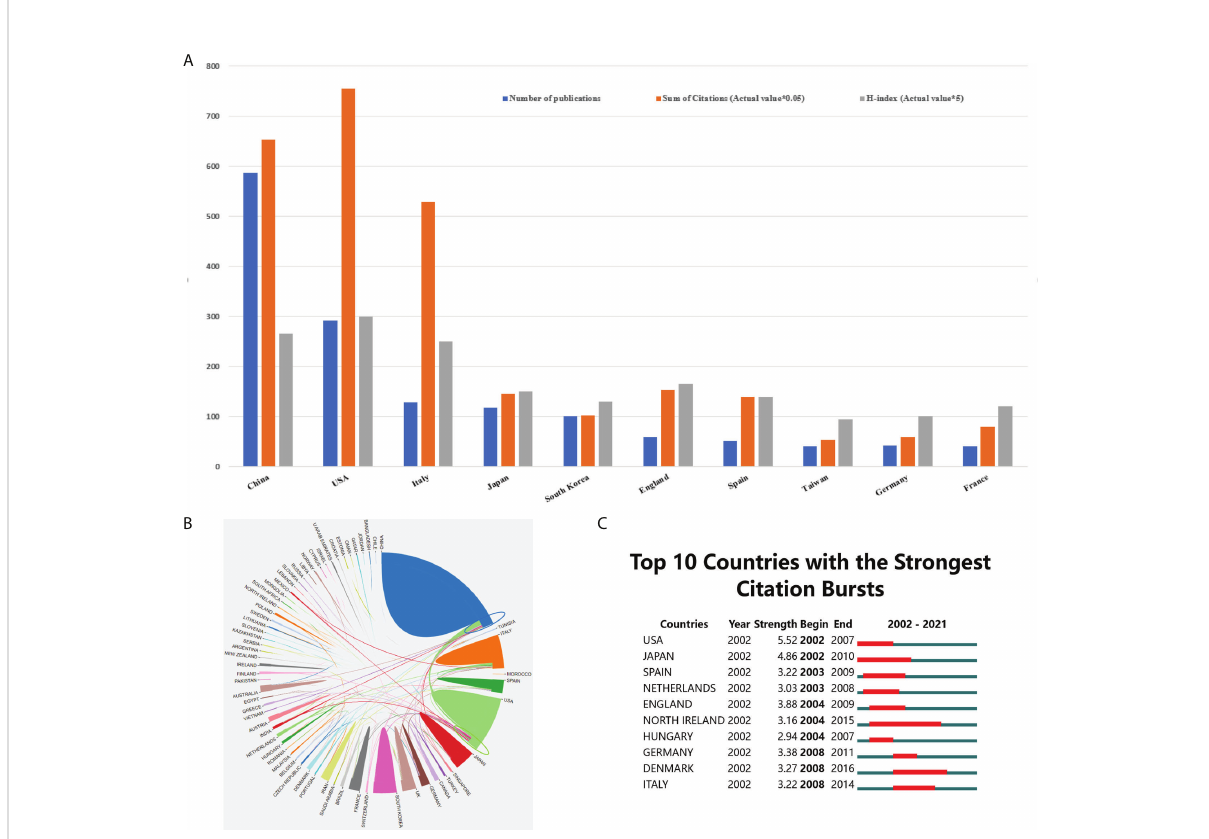
FIGURE 3 The contributions of different countries/regions to research concerning drug resistance and colorectal cancer. (A) The number of publications, citation frequency (×0.05), and H-index (×5) in the top 10 countries or regions; (B) The cooperation of countries/regions from 2002 to 2021; more lines emanating from a country indicate closer international cooperation; (C) Top 10 countries with the strongest citation bursts. The blue line represents the time axis, and the red portion on the blue time axis represents the interval at which the burst was found, including the start year, end year, and burst